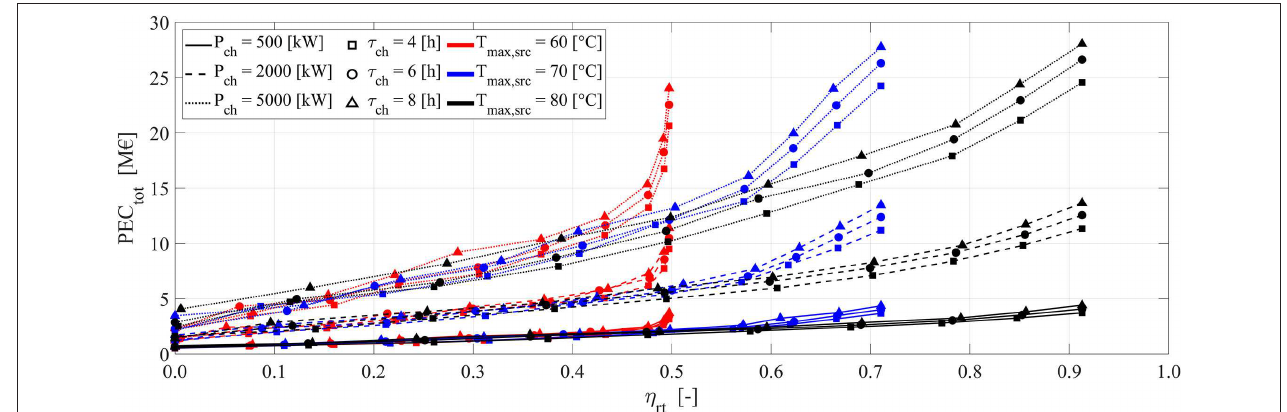
FIGURE 2 | Pareto fronts of electrical round-trip efficiency η rt and total equipment purchasing cost PEC tot . Results are reported for several heat source temperatures T in , src , several storage duration τ ch , and system nominal power input ˙ W hp